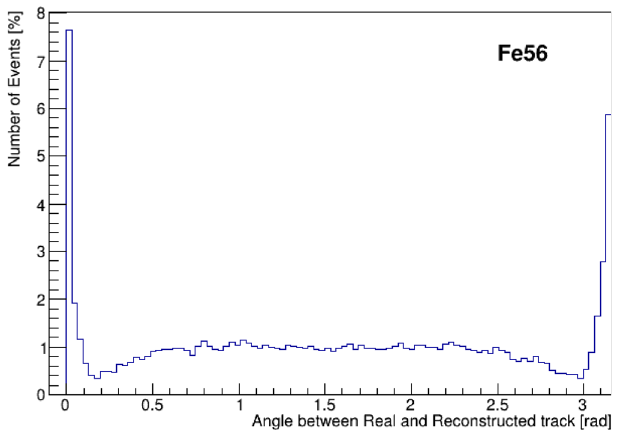
Fig. 2. Distribution of the angle between the real (known from MC) and reconstructed track.